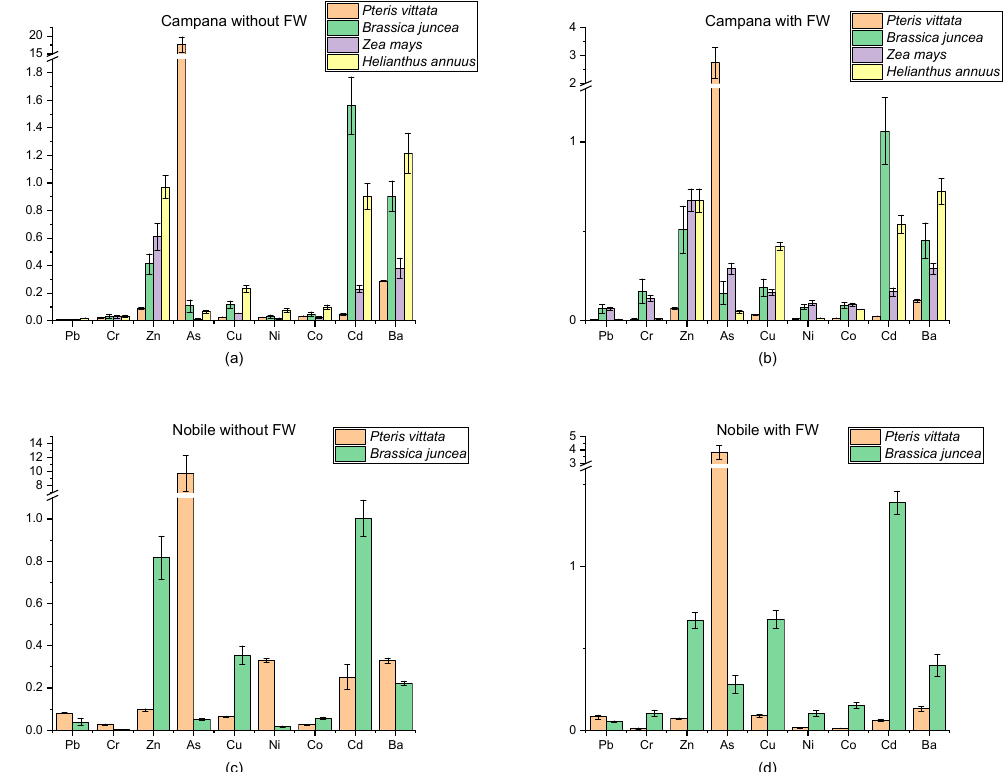
Figure 4. Translocation factors (TFs) of plants chosen for phytoremediation and grown in ( a ) Campana without FW, ( b ) Campana with FW, ( c ) Nobile without FW and ( d ) Nobile with FW. Values are expressed as mean ± SD.